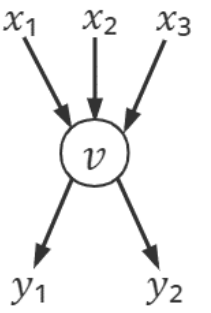
Figure 1. Example of coding node.